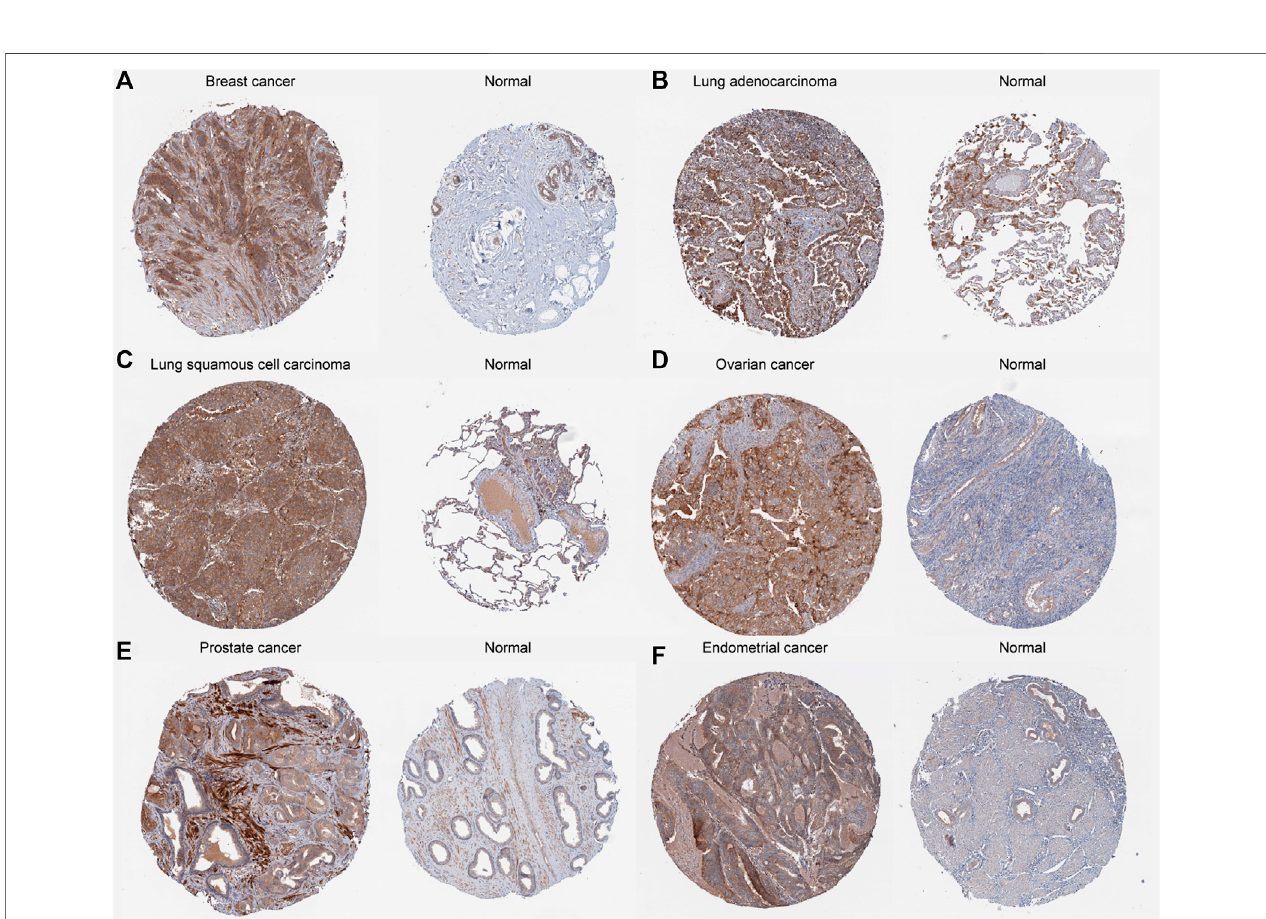
FIGURE 3 | Representative ALKBH7 immunohistochemical staining in tumor and normal tissues. The expression of ALKBH7 gene in BRCA (A) , LUAD (B) , LUSC (C) , OV (D) , PRAD (E) , and UCEC (F) is signi fi cantly higher than that in the corresponding normal tissues.